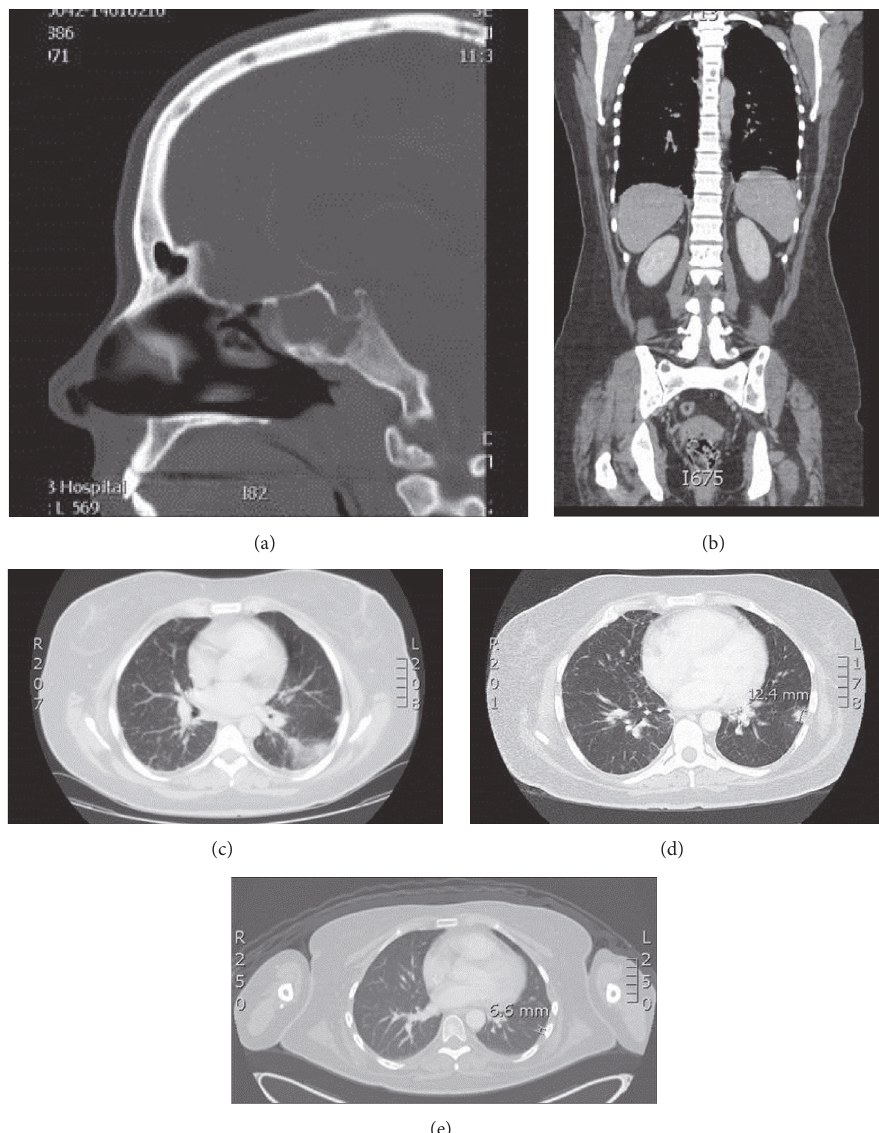
Figure 1: (a) Sagittal view of the sinus on computerized tomography (CT) showing the complete opacification of the right sphenoid sinus which was proven to be ALCL involvement by biopsy. (b) Axial view of CT C/A/P obtained at the time of diagnosis showing the diffuse osseous metastatic spread of disease involving vertebral bodies, pelvis, and humerus. (c) Representative lung field section of the CT C/A/P in (b) showing the numerous subcentimeter nodular densities within the lung parenchyma and along the margins of the fissures and pleural margins. Patient did not have significant lymphadenopathy (not shown). (d) Representative CT lung field performed after the first dose of hyperCVAD without BV showing interval progression of lung disease as well as development of new right hilar adenopathy (not shown). (e) Representative lung field of PET-CT (level approximates that of image (d)) showing resolution on the reticulonodular opacities and decrease in size of the largest subpleural nodule in the L lung. No PET avidity noted. Not shown are persistent diffuse lytic lesions that are not PET